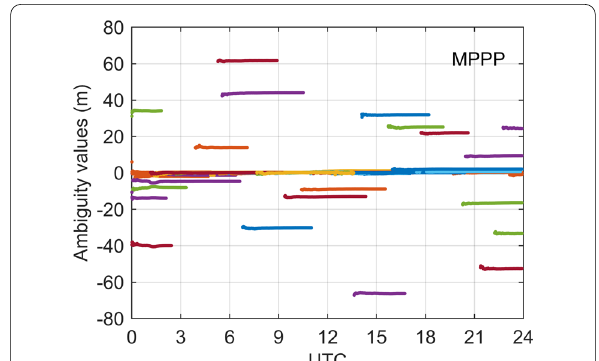
Fig. 4 Estimated ambiguity parameters of L1 frequency at station MTDN using the MPPP model. Different colors correspond to different satellites